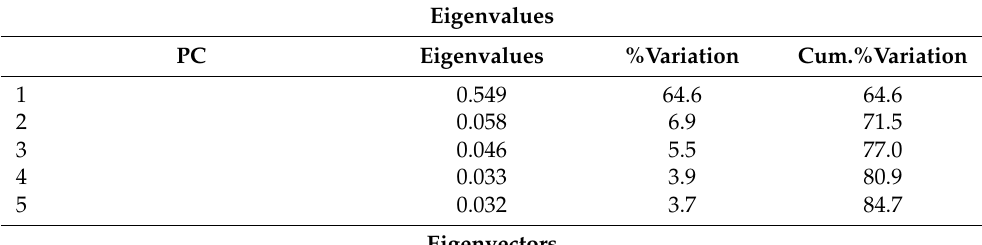
Figure 7. PCA plot for standardized metric values of LAP (numbers refer to each site). Table 4. PCA eigenvalues and eigenvectors.